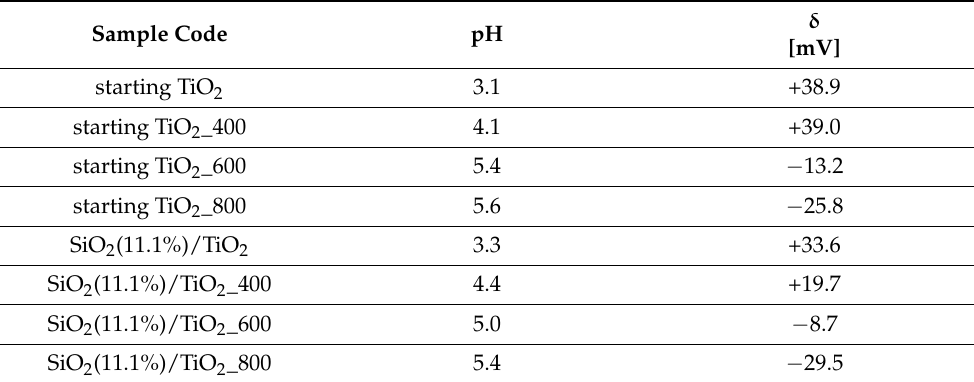
Table 3. The zeta potential values of starting TiO 2 , reference samples and fumed silica-modified photocatalysts prior to and after heat treatment.